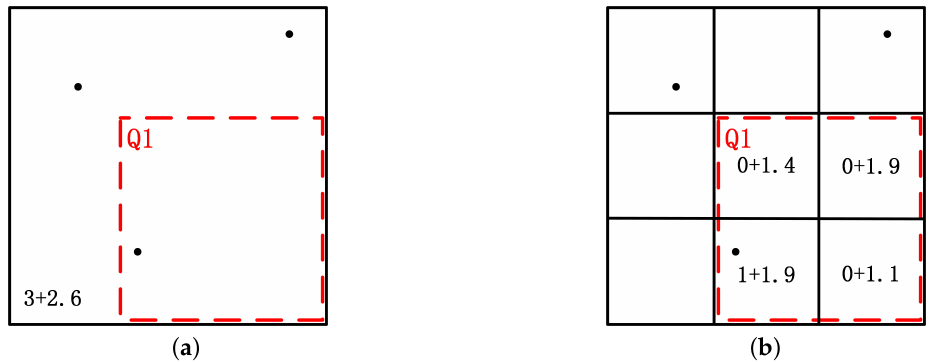
Figure 3. The relationship of sparse data distribution and partition structure. ( a ) example of sparse distribution; ( b ) corresponding partition and range query.